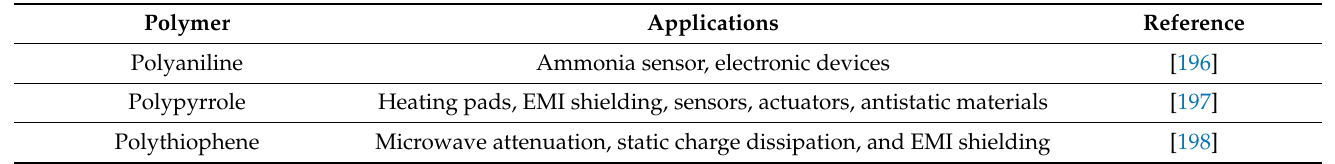
Table 6. Applications of electrically conductive